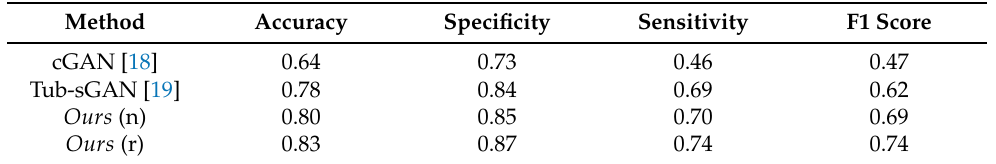
Table 2. Evaluation of the DR severity prediction. Conditional Generative Adversarial Network: